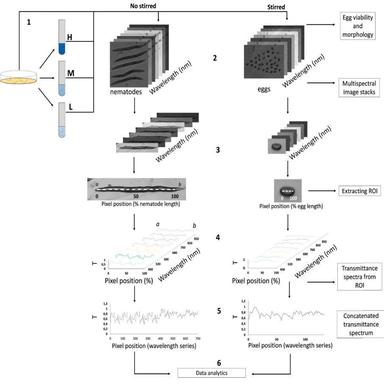
Experimental procedure.